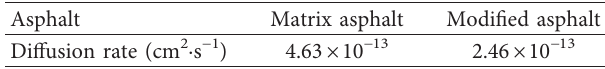
Table 8: The diffusion rate of water in different